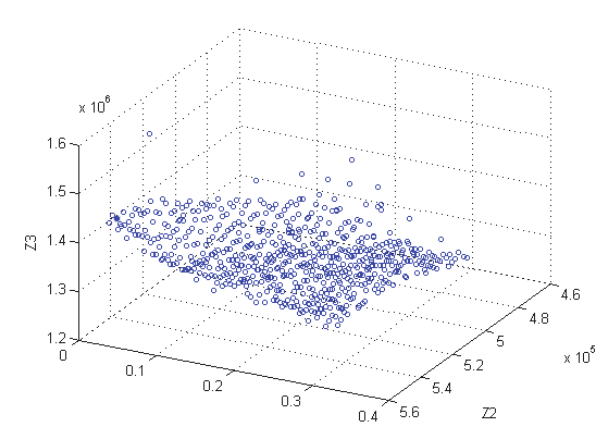
Fig. 6. Pareto optimal solutions of the East Azerbaijan relief logistics